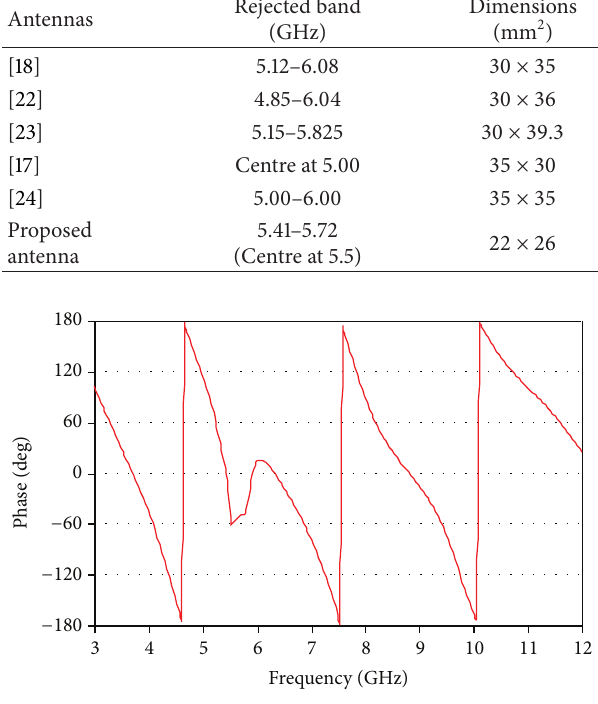
good radiation efficiency throughout the entire UWB range without 5.5 GHz rejected band. The efficiency reduces sharply at 5.5 GHz band that illustrates the effect of rejected band. The comparisons between existing and proposed band-rejected UWB antennas are listed in Table 1, which bears testimony to the compact profile of the proposed